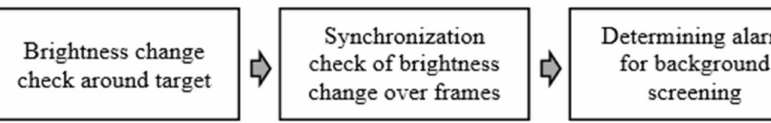
Figure 7. Procedure of background screening